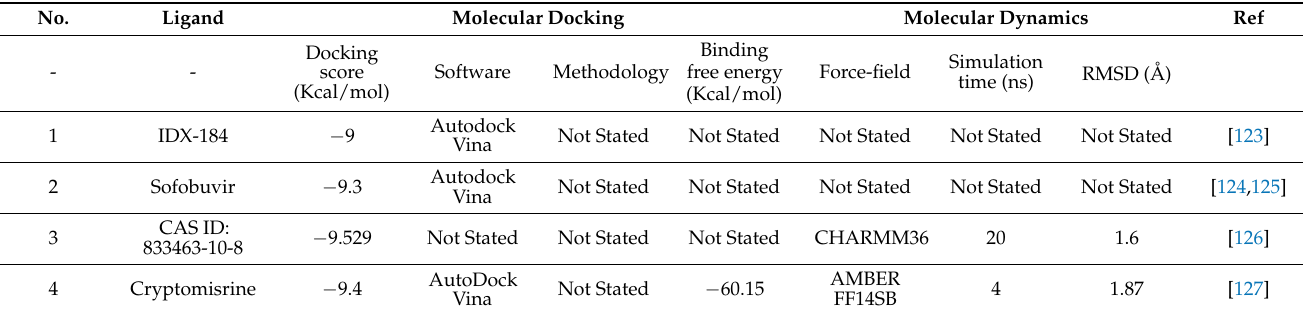
Table 3. Screening of FDA-repurposed drugs and natural compounds for RNA-dependent RNA polymerase enzyme target.